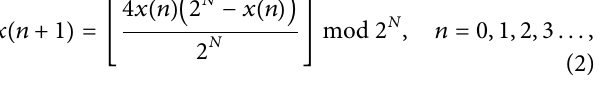
; (b) when 𝜇 ∈ [0, 4] 𝜇 ∈ [3.9, 4]